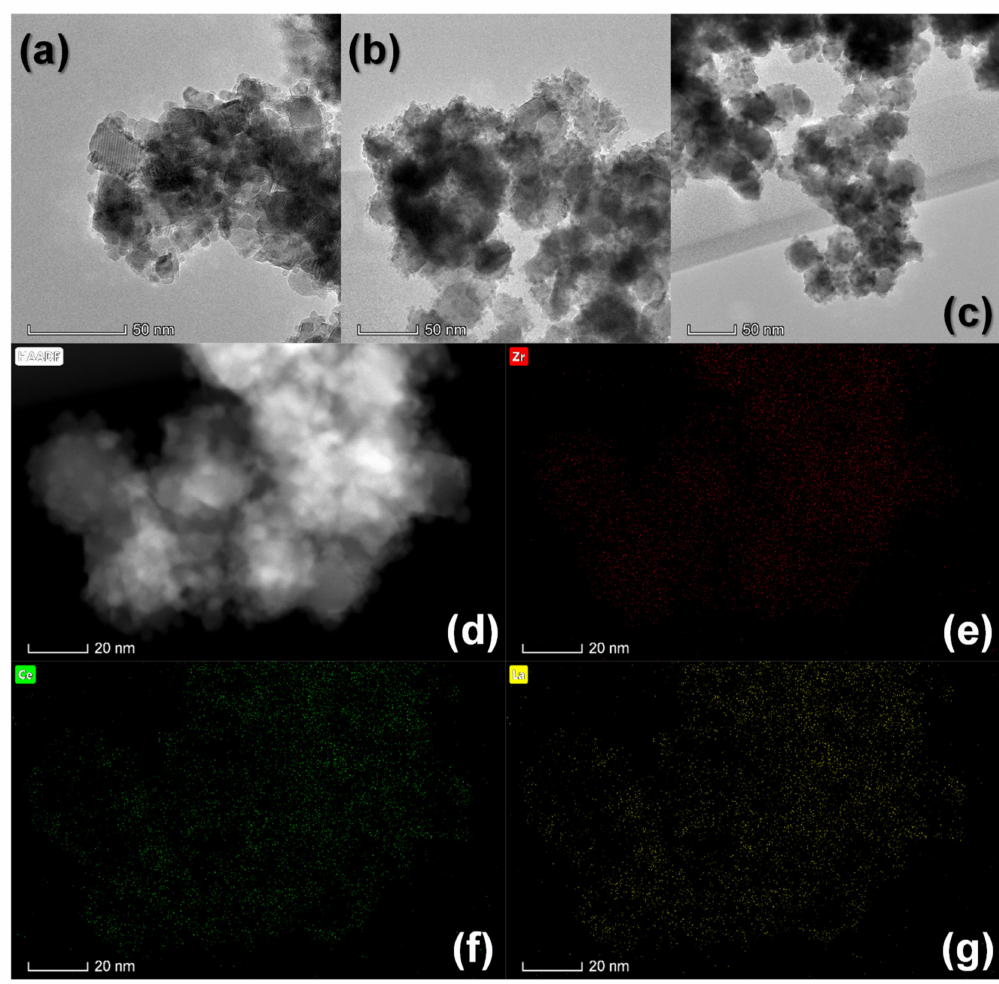
Figure 3. Representative TEM images for the fresh samples: ( a ) ZrO 2 -CeO 2 , ( b ) ZrO 2 -Ce 0.87 Y 0.13 O 1.935 , and ( c ) ZrO 2 -Ce 0.87 La 0.13 O 1.935 . ( d ) High angle annular dark field-scanning transmission